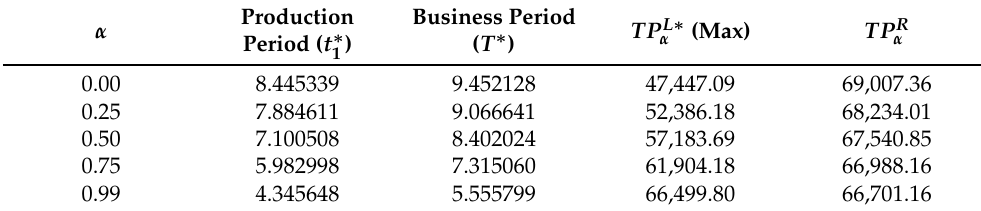
Table 2. Optimum results of Example 1 for maximizing TP L α